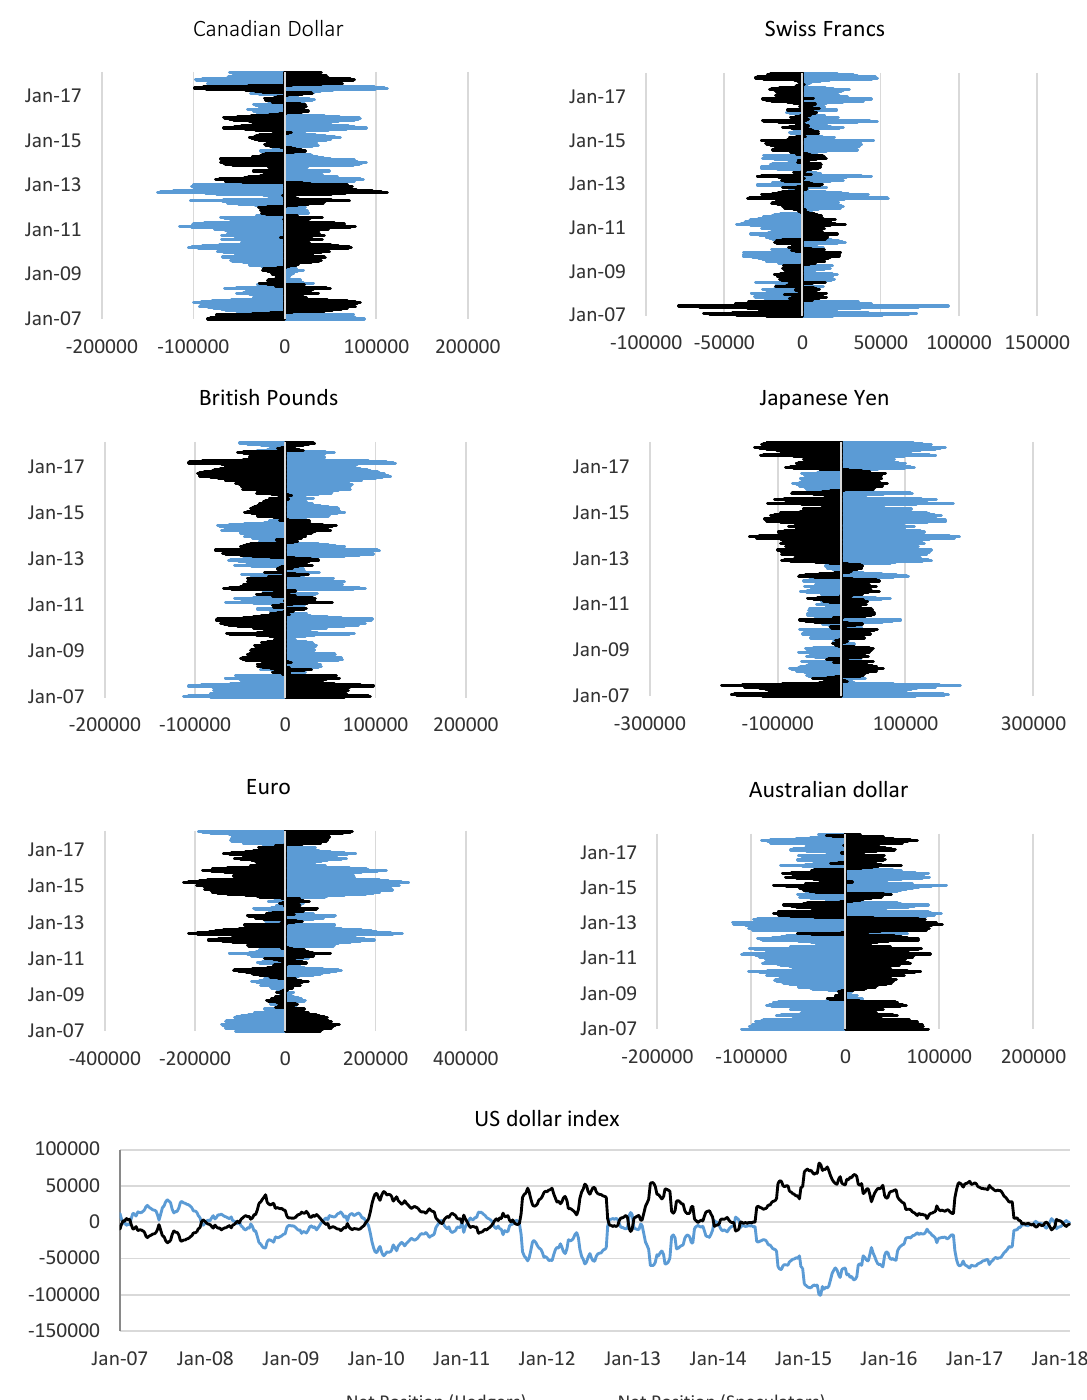
Figure 1. Net positions in major foreign currencies